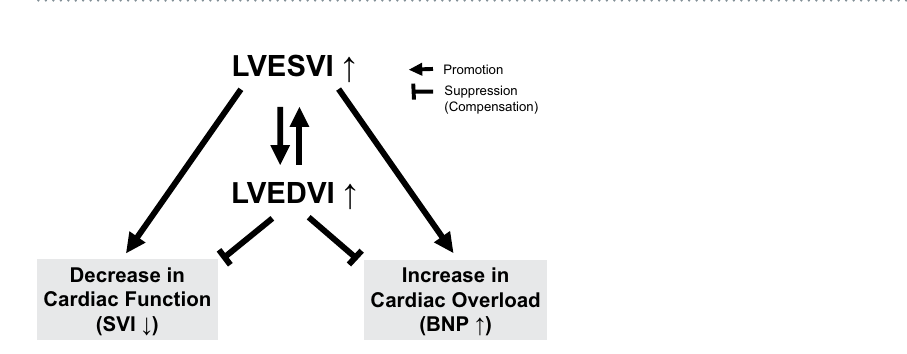
Figure 6. Explanatory drawing of the typical pattern of changes in the virtual cardiac shapes and the end-systolic and end-diastolic left ventricular diameters of the remodeling heart. The circles indicate the endocardium of the left ventricle in each state, the end-systolic phase and end-diastolic phase. The left ventricular cavity is dilated in the end-systolic phase and/or end-diastolic phase.